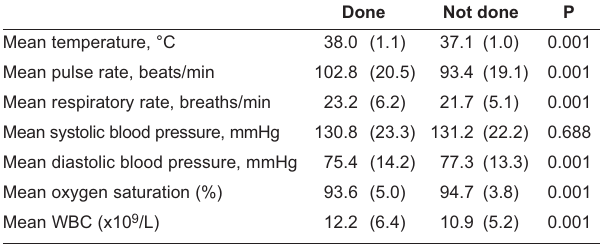
Blood culture Positive